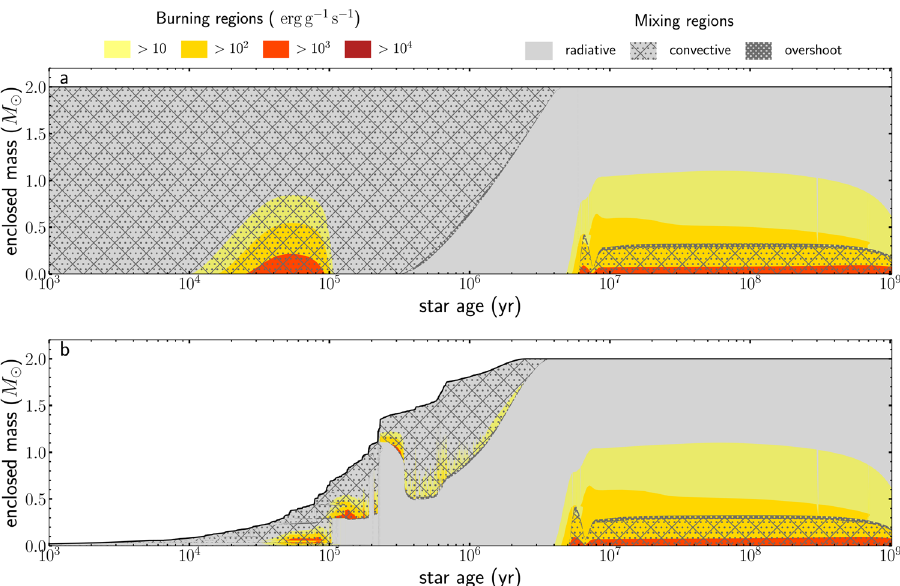
Fig. 1 | Comparison of the internal structure of the calculated evolution mod- els.a Kippenhahndiagramfortheclassicmodel. b Kippenhahndiagramofthedisk- mediated accretion model #28. In both panels, the black line shows the stellar mass